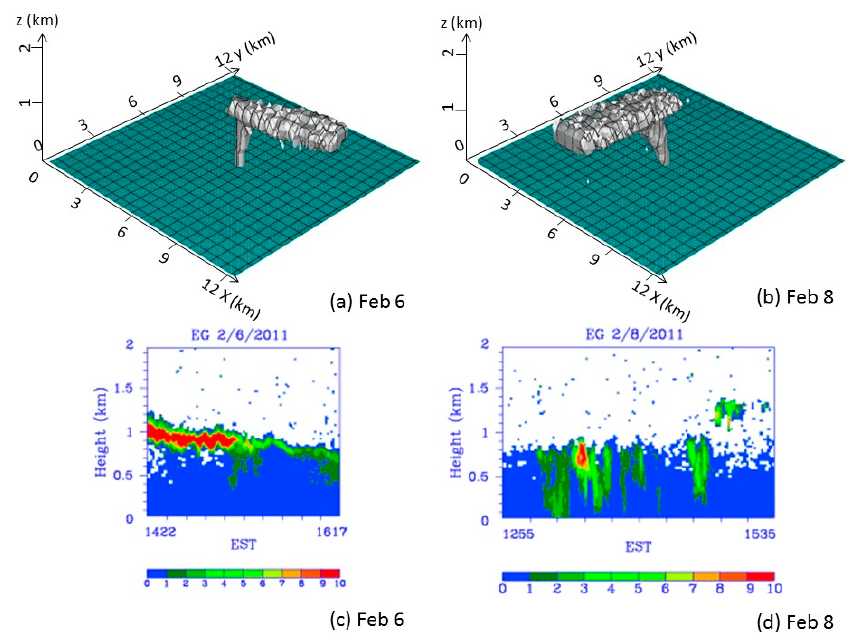
Figure 6. Smoke plumes at Eglin on 6 and 8 February at 1400 local time. ( a , b ) are Daysmoke simulations. ( c , d ) are the corresponding ceilometer detections with the horizontal axis indicating local time (from [24]).